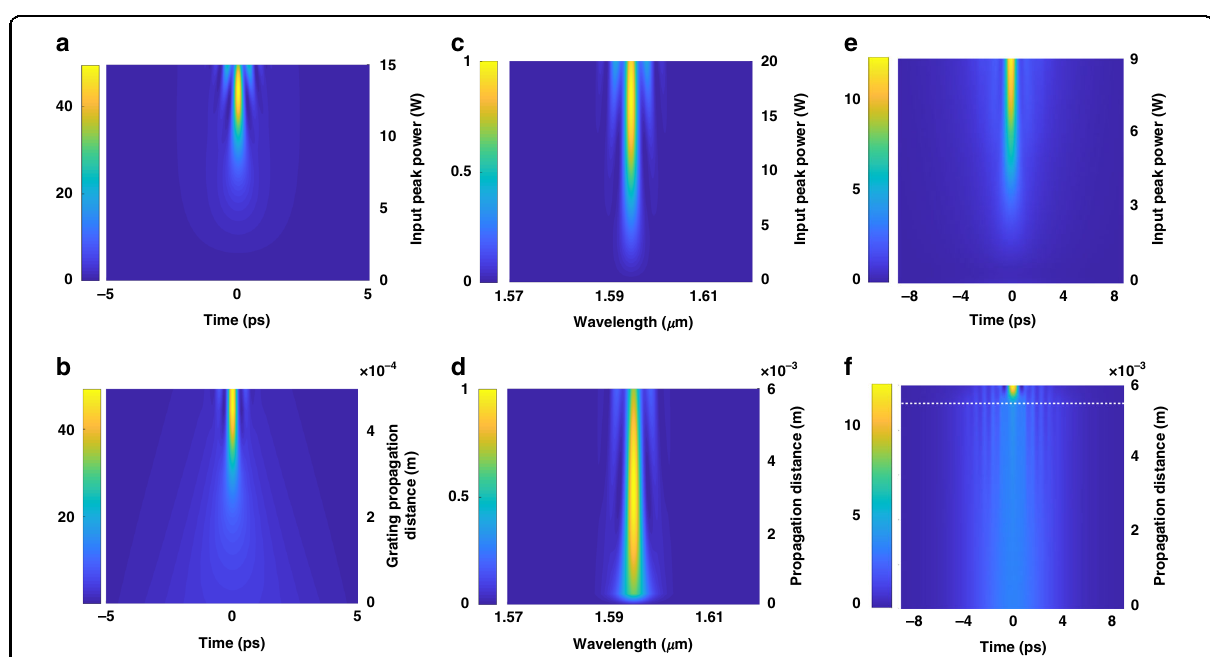
Fig. 3 Numerically calculated pulse propagation dynamics for Device 1 and Device 2 . a Temporal compression dynamics of Device 1 , designed for high temporal compression, as a function of the input peak power for 5.8 ps input pulses. b Pulse temporal evolution as it propagates through the grating at a peak power of 13 W (pulse energy = 75.4 pJ). c Spectral compression dynamics as a function of input peak power for input pulses of 480 fs propagating in Device 2 . Optimum spectral compression is achieved at a peak power of 18 W (pulse energy = 8.6 pJ). d Pulse spectral evolution as a function of propagation length for a peak power of 18.2 W (pulse energy = 8.7 pJ). e Output of the temporal pulse compressor ( Device 2 ), as a function of input peak power for input pulses of 5.6 ps. Optimum temporal compression is achieved at a peak power of 6 W (pulse energy = 33.6 pJ). f Pulse temporal evolution in Device 2 as a function of propagation length for a peak power of 9 W (pulse energy = 50.4 pJ). The dashed white line denotes where the USRN waveguide ends and the dispersive stage begins. Temporal compression proceeds quickly once pulses enter the dispersive stage. Plots ( a , b ) utilize Device 1 , with β 2(grating) = − 600 ps 2 m − 1 , designed for high temporal compression. Plots ( c – f ) utilize Device 2 ( β 2(grating) = − 890 ps 2 m − 1 ), designed for reversibility in the spectro-temporal compression function. Color bars in a , b , e , f denote the output pulse peak power. Color bars in c , d denote the output pulse spectral